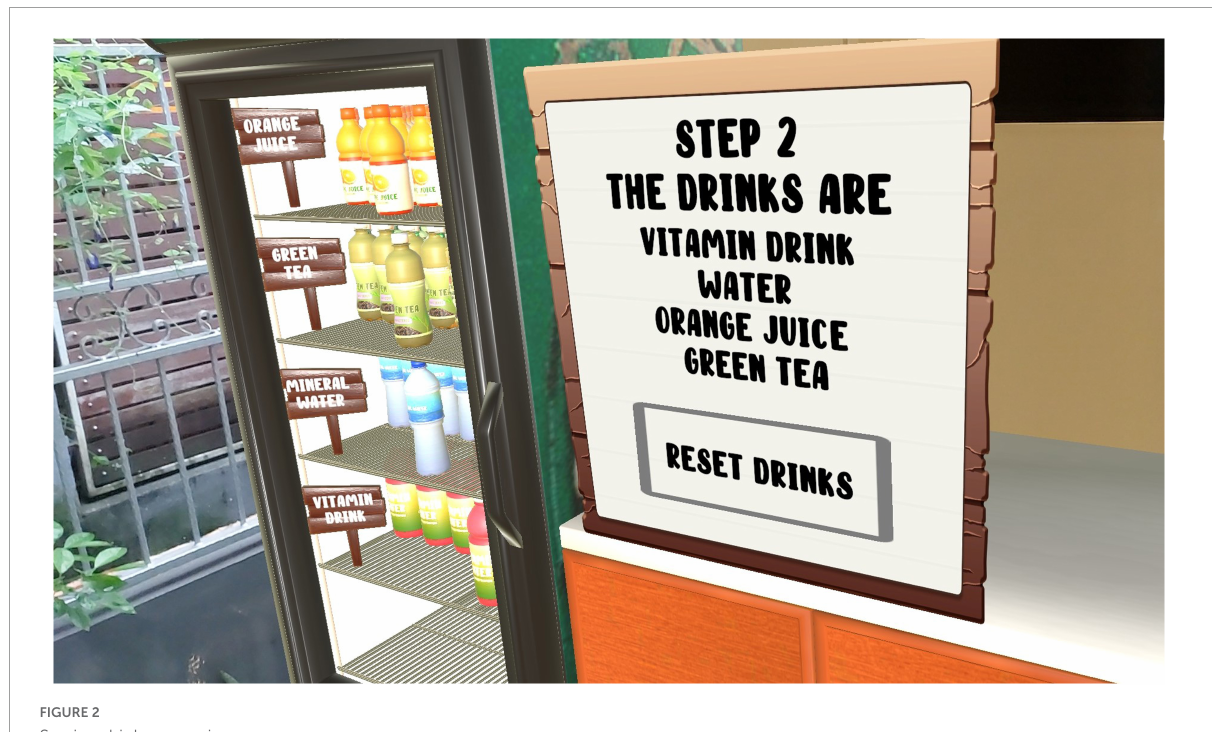
FIGURE2 Serving drinks